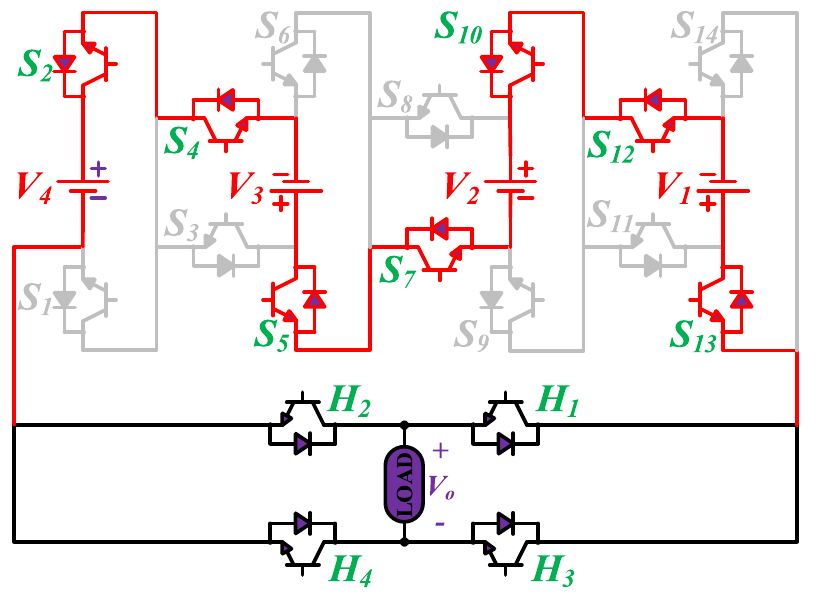
an approaching sinusoidal voltage without using any output filter. The FFT and THD analysis depict the output voltage THD of 1.04%, which is within limits specified by IEEE 519 standard for a medium voltage system. The efficiency plot shows that the efficiency of the proposed MWMLI for resistive loads is above 90%, whereas for 0.8PF loads is slightly less than 90%. The efficiency plot also shows that the efficiency starts to decrease slightly by increasing the output power. This effect is justified as the conduction loss depends on the current square. The